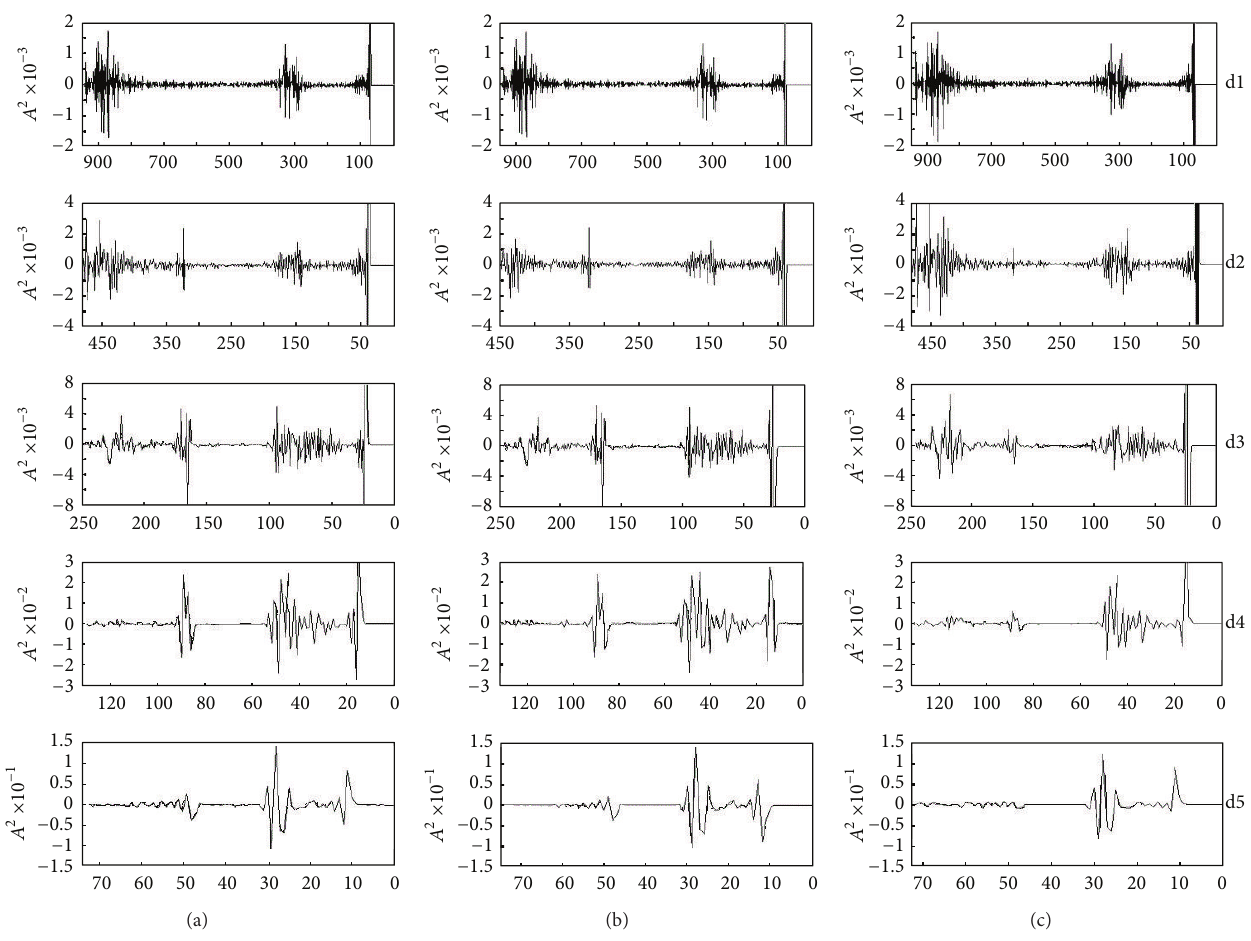
Figure 3: The result of multiresolution decomposition of normal, early carcinoma, and advanced carcinoma tissues’ FTIR with discrete wavelet transformation. (a) Normal tissues; (b) early carcinoma tissues; (c) advanced carcinoma